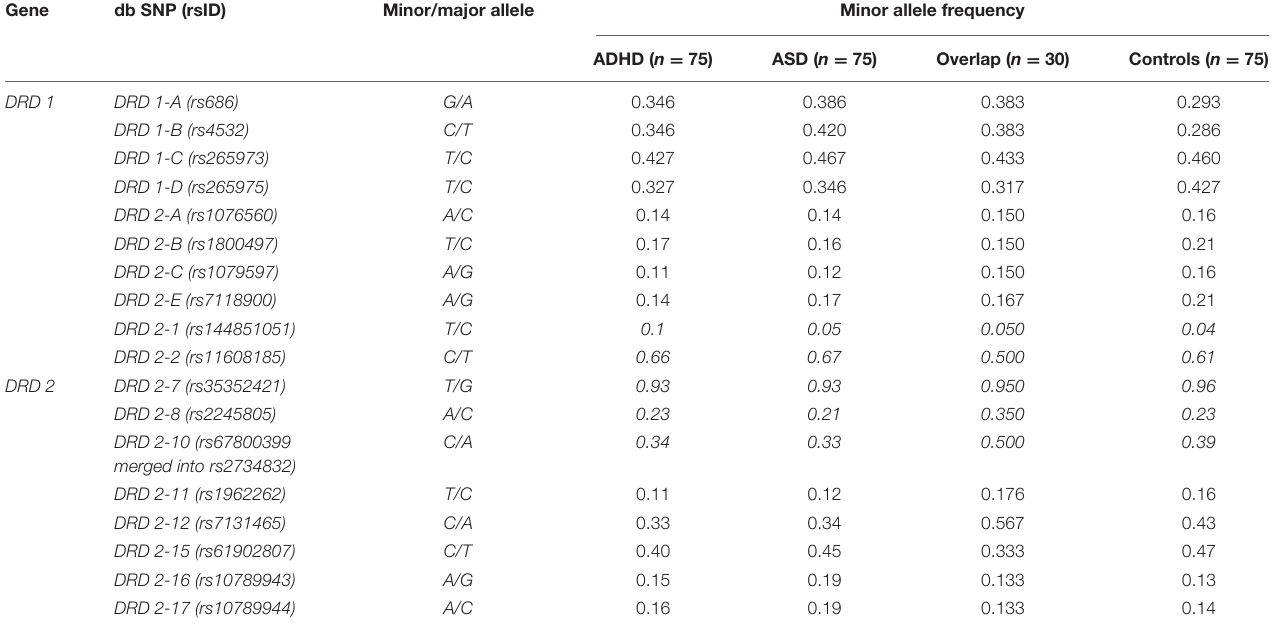
TABLE 3 | Allele frequencies distribution of SNPs in study groups. Gene db SNP (rsID)